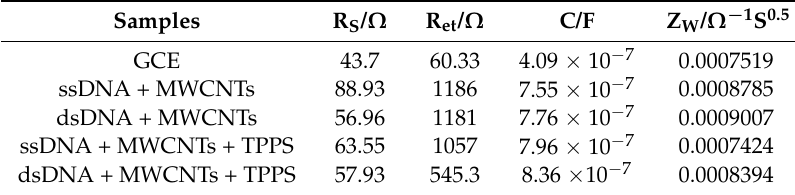
Table 2. Equivalent circuit component